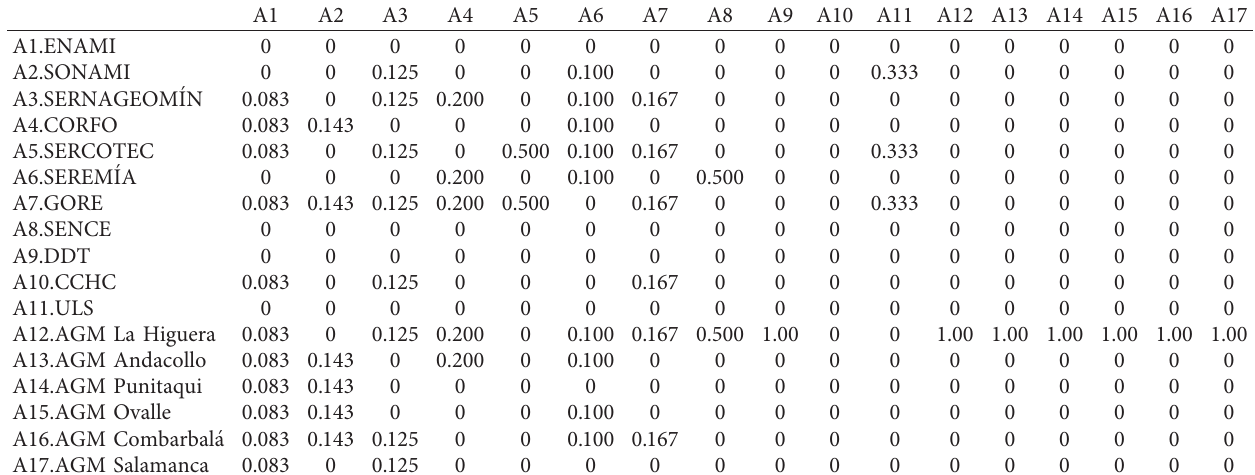
Table 5: Weighted supermatrix.